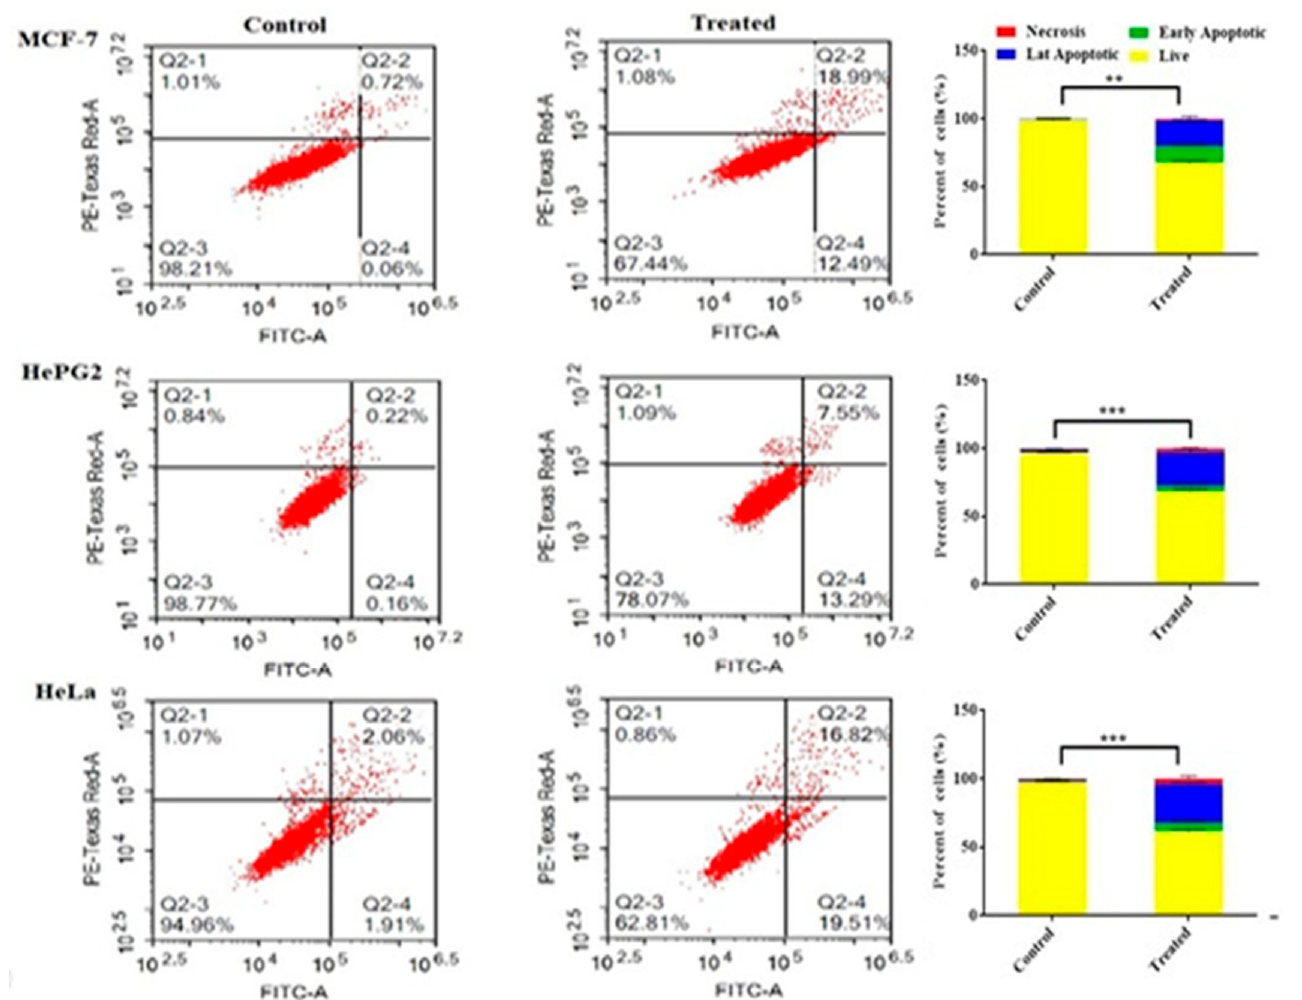
Figure 3. Apoptosis/necrosis assessment for compound 2 against MCF-7, HepG2, and HeLa cells subjected to previous treatment for 48 h, and apoptosis/necrosis quantified using flow cytometry. Data are presented as the mean ± SD; n = 3; ** p < 0.01 and *** p <